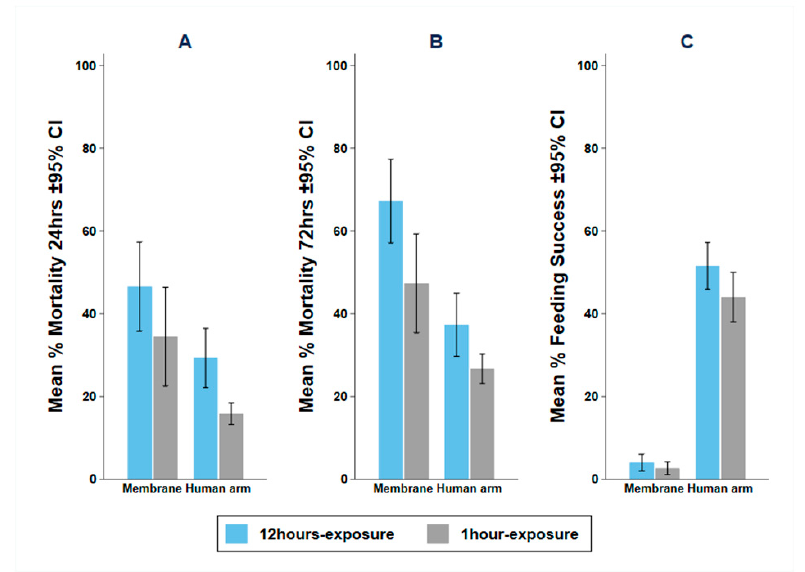
Figure 5. Mean and 95% Confidence Interval (CI) for ( A ) 24-h (M24); ( B ) 72-h (M72); and ( C ) blood feeding success (BFS) with 100 pyrethroid-resistant Anopheles arabiensis mosquitoes with 12 h or 1 h exposure time in the WHO tunnel bioassay using Hemotek ® membrane or human arm as bait.